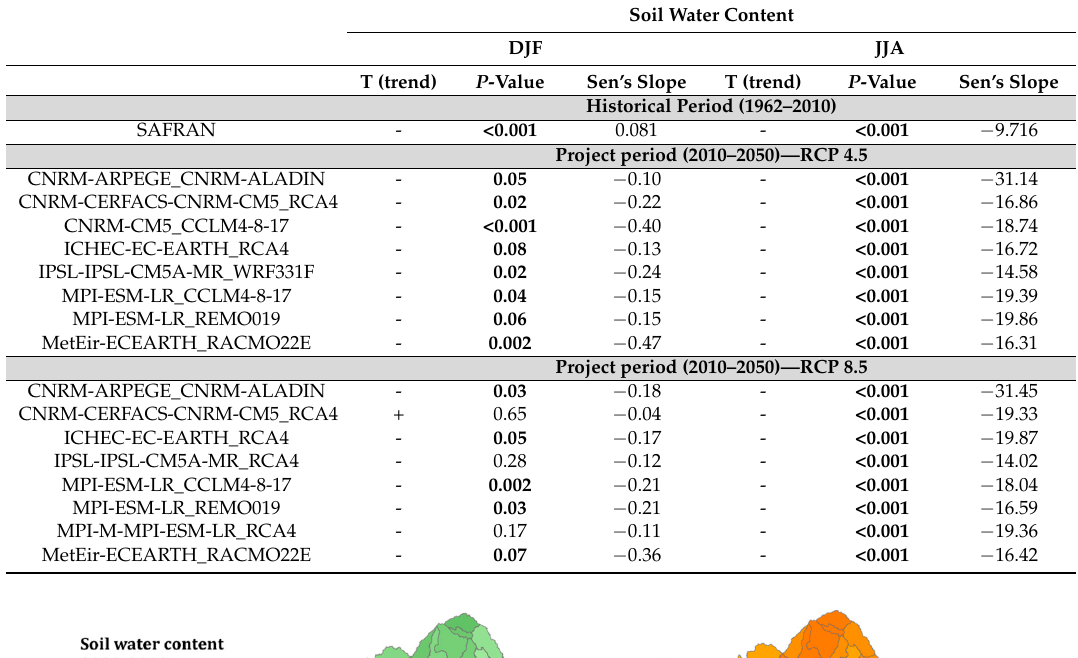
Table 11. Trend in soil water content over winter (DJF) and summer (JJA) seasons at watershed scale, for SAFRAN (historical period) and climatic ensemble (projected period). Bold numbers are significant trend considering α = 0.1 and underlined numbers considering.